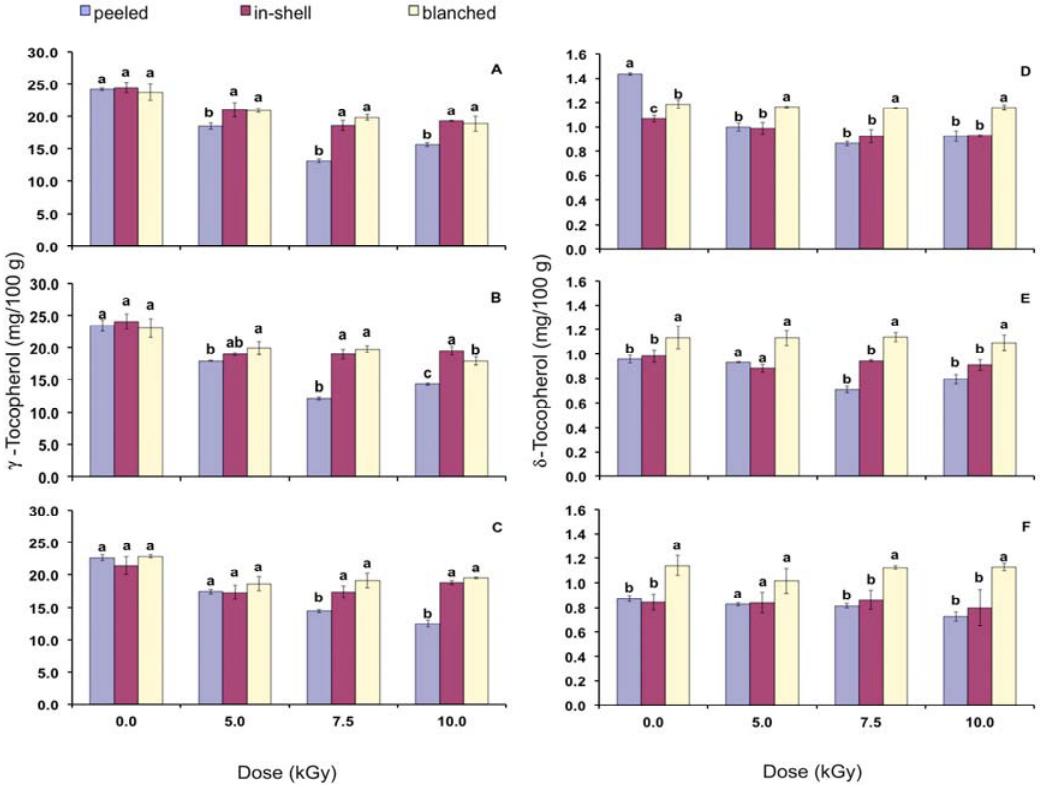
Figure 2. γ -Tocopherol content on time zero ( A ), in the third ( B ) and sixth month storage ( C ). δ -Tocopherol content on time zero ( D ), in the third ( E ) and in the sixth month storage ( F ). Error bars represent standard deviations of triplicate measurements. Means with the same letter within a gamma radiation dose are not statistically different by Tukey’s multiple test ( p <